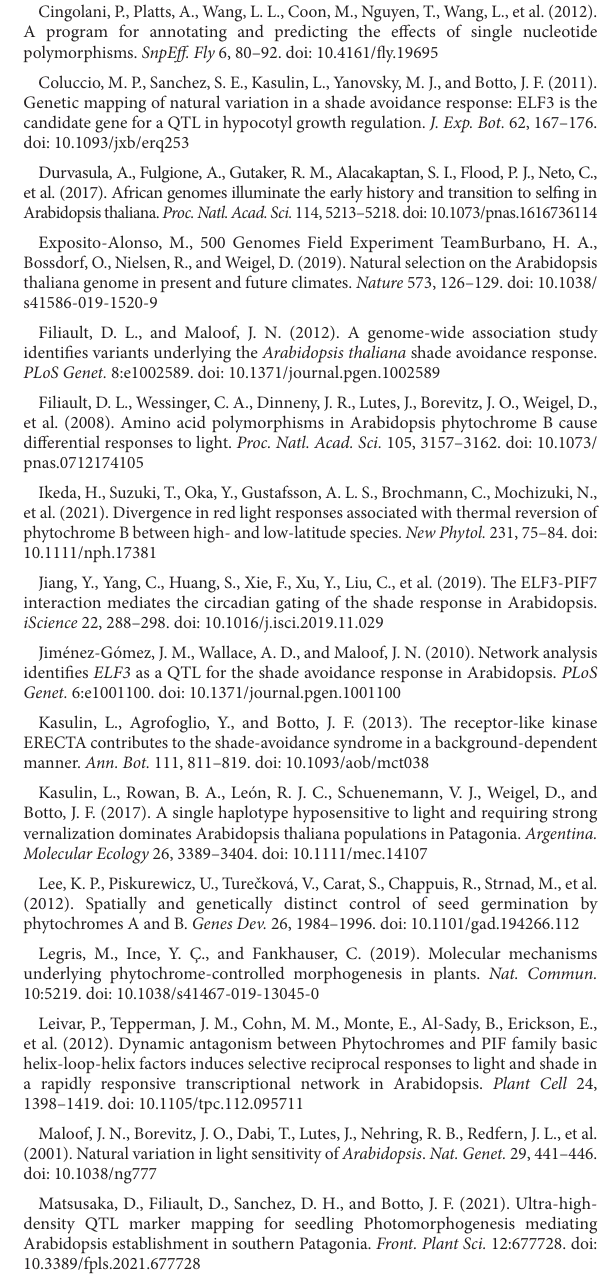
hypocotyl length in red continuous and darkness for each PHYB polymorphism in independent transgenic lines. Mean ± SE (n=2). SUPPLEMENTARY FIGURE S9 Functional variation of PHYB polymorphisms in seed germination induced by a red or far-red pulse for each PHYB polymorphism in independent transgenic lines. Mean ± SE ( n = 3). SUPPLEMENTARY TABLE S7 SNPs into the PHYB gene detected in the five samples of RNAseq of Patagonia (for more references see Kasulin et al., 2017). The table shows the SNPs in the promoter ( − 2,000b), 5 ′ UTR, exons, and introns of the PHYB . The three non-synonymous polymorphisms detected in the cDNA of the PHYB correspond to M2 (I143L), M3 (V980I), and M4